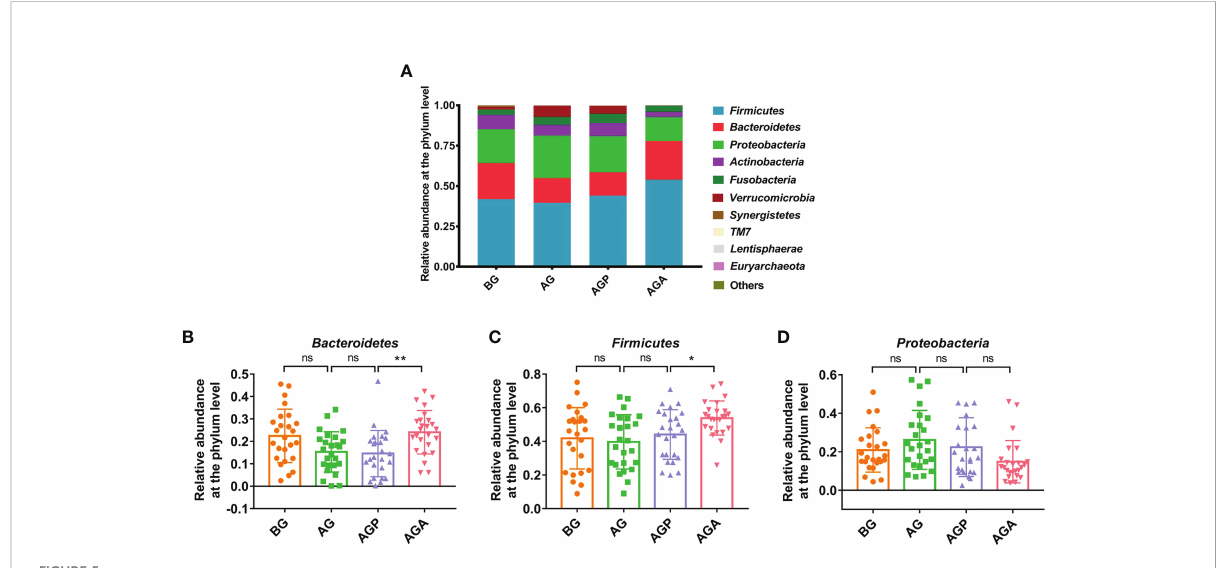
FIGURE 5 C butyricum altered gut microbial Composition of Patients with gastric cancer after Gastrectomy at phylum level. (A) the relative abundance of intestinal microbiota at the phylum level; (B) Bacteroidetes ; (C) Firmicute ; (D) Proteobacteria . BG, gastric cancer patients before gastrectomy (n=25); AG, gastric cancer patients after gastrectomy (n=25); AGP, gastric cancer patients and treatment with the placebo after gastrectomy (n=45); AGA, gastric cancer patients and treatment with the C butyricum after gastrectomy (n=47). Data are presented as means ± SD. ns, no signi fi cance, P > 0.05, * P < 0.05, ** P <